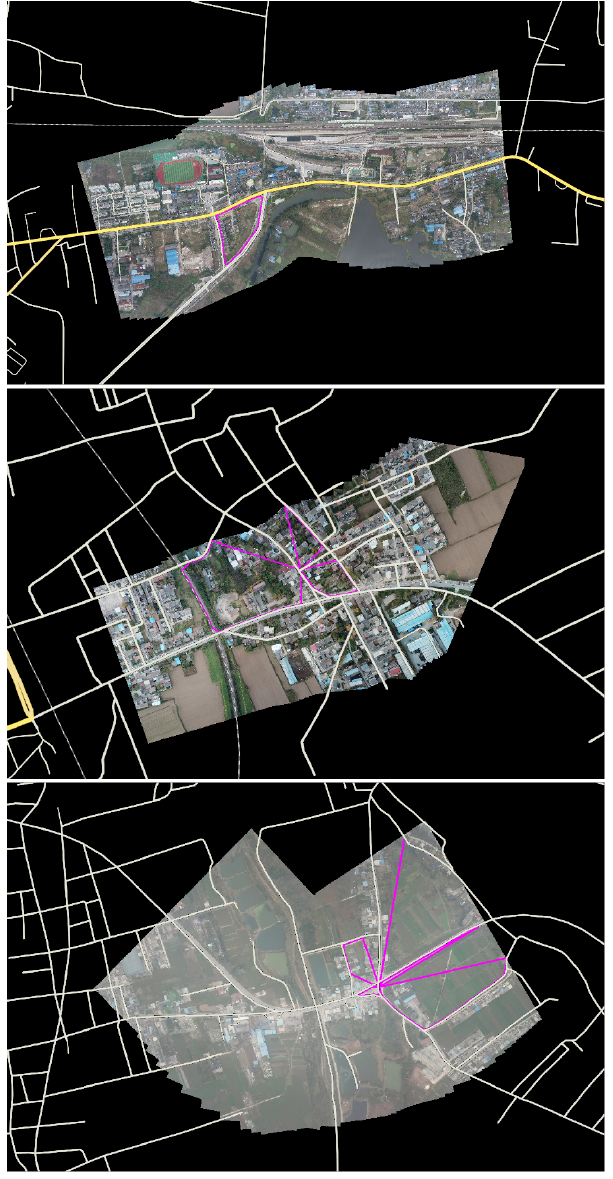
Figure 12. Successful geolocalization results. The query aerial image mosaics are projected onto the reference road maps. The PICFs from which the homography transformations are estimated are shown in purple. The top mosaic is from Fengyang, while the other two mosaics are from Xian. Even though the roads in the aerial images cannot be aligned to those in the reference road map exactly in some cases, the geolocalization results can be used as a good initial estimation to calculate more accurate transformation. However, this is not the target of this